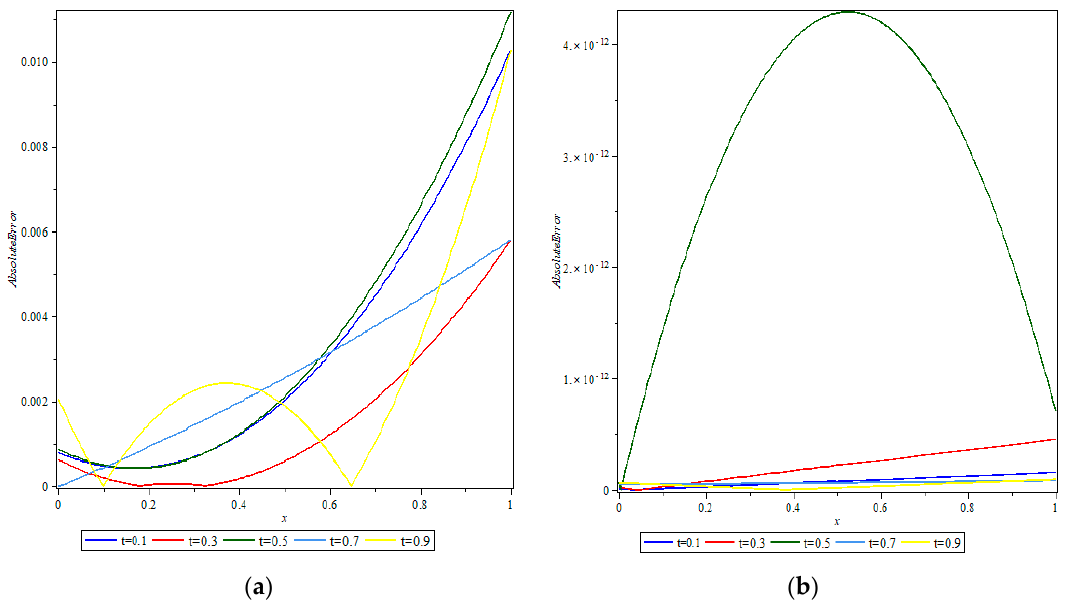
Figure 1. ( a ) The absolute errors | u exactsol − u GWGM | at di ff erent times, when α = 1; ( b ) the absolute errors | u exactsol − u GWCM | at di ff erent times, when α = 1.